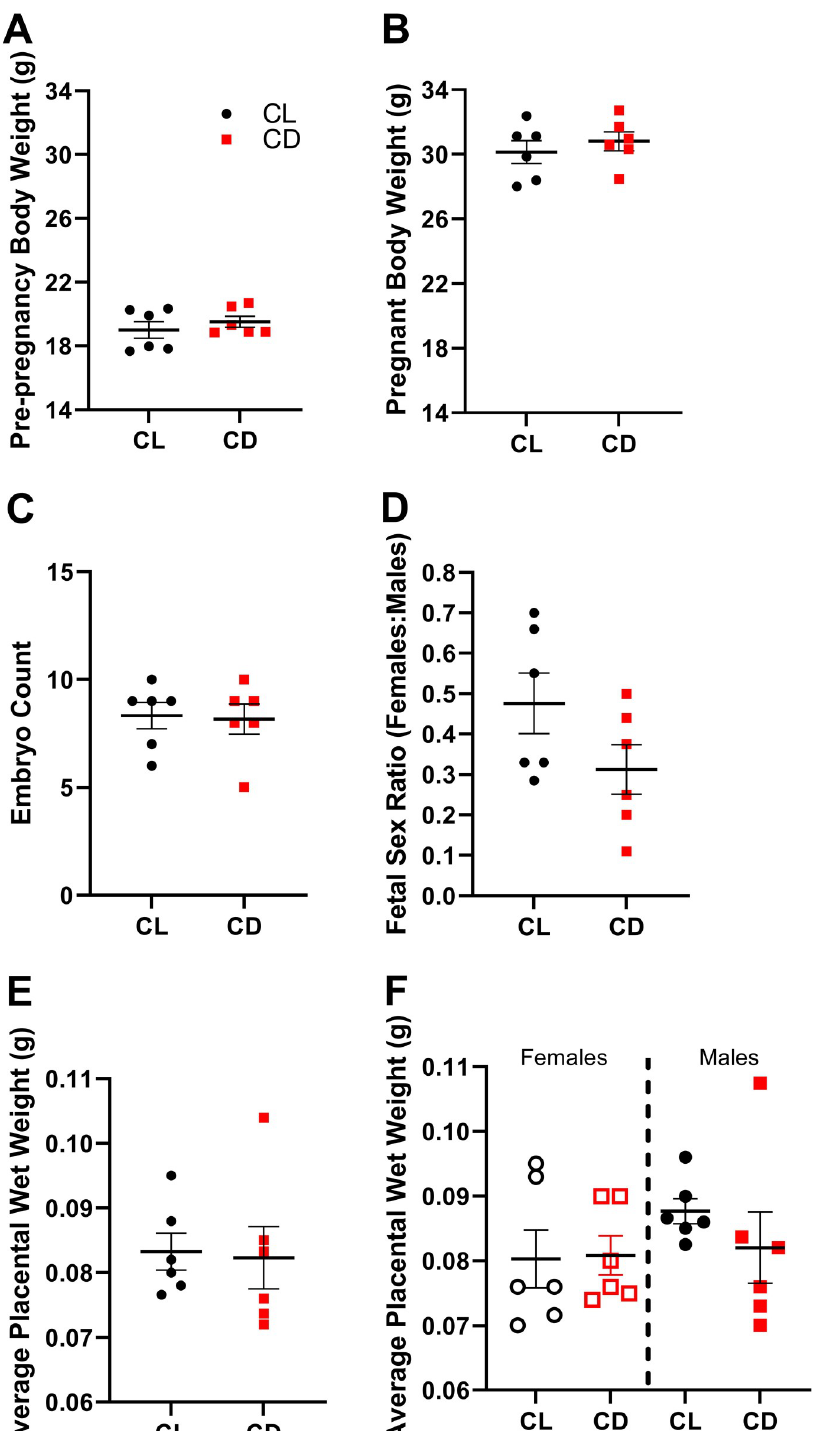
Fig 1. Light treatment did not alter dam or fetal outcomes. Body weight (grams) of female mice (CL n = 6, CD n = 6) from which placental samples were collected ( A ) just prior to pairing for timed breeding (Student’s unpaired 2-tailed t-test, t = 0.83, df = 10, p = 0.43) and ( B ) when pregnant at E15.5 just prior to tissue collection (Student’s unpaired 2-tailed t-test, t = 0.72, df = 10, p = 0.49). ( C ) Number of viable embryos per dam counted within the uterine horns (Student’s 2-tailed unpaired t-test, t = 0.18, df = 10, p = 0.86). ( D ) Sex ratio of viable embryos per dam, as